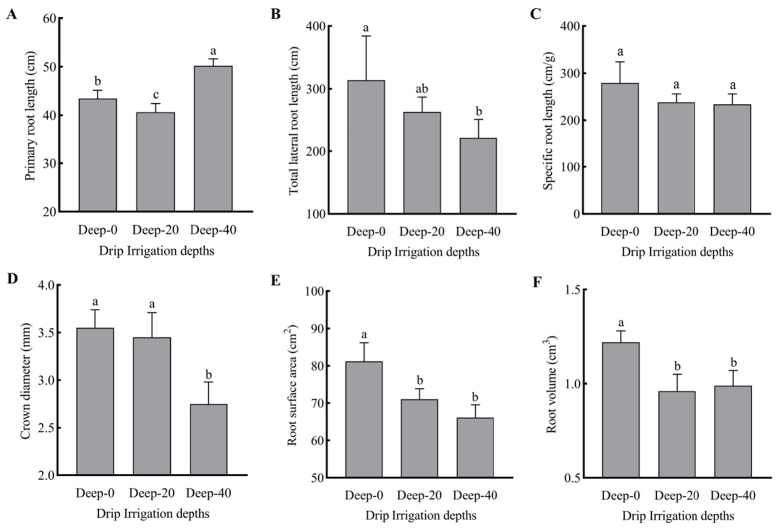
Figure 5. Root morphological traits of alfalfa plants under three drip irrigation depths. ( A ) Primary root length, ( B ) total lateral root length, ( C ) specific root length, ( D ) crown diameter, ( E ) root surface area, and ( F ) root volume. Lower ‐ case letters above bars indicate a significant difference ( p < 0.05, LSD